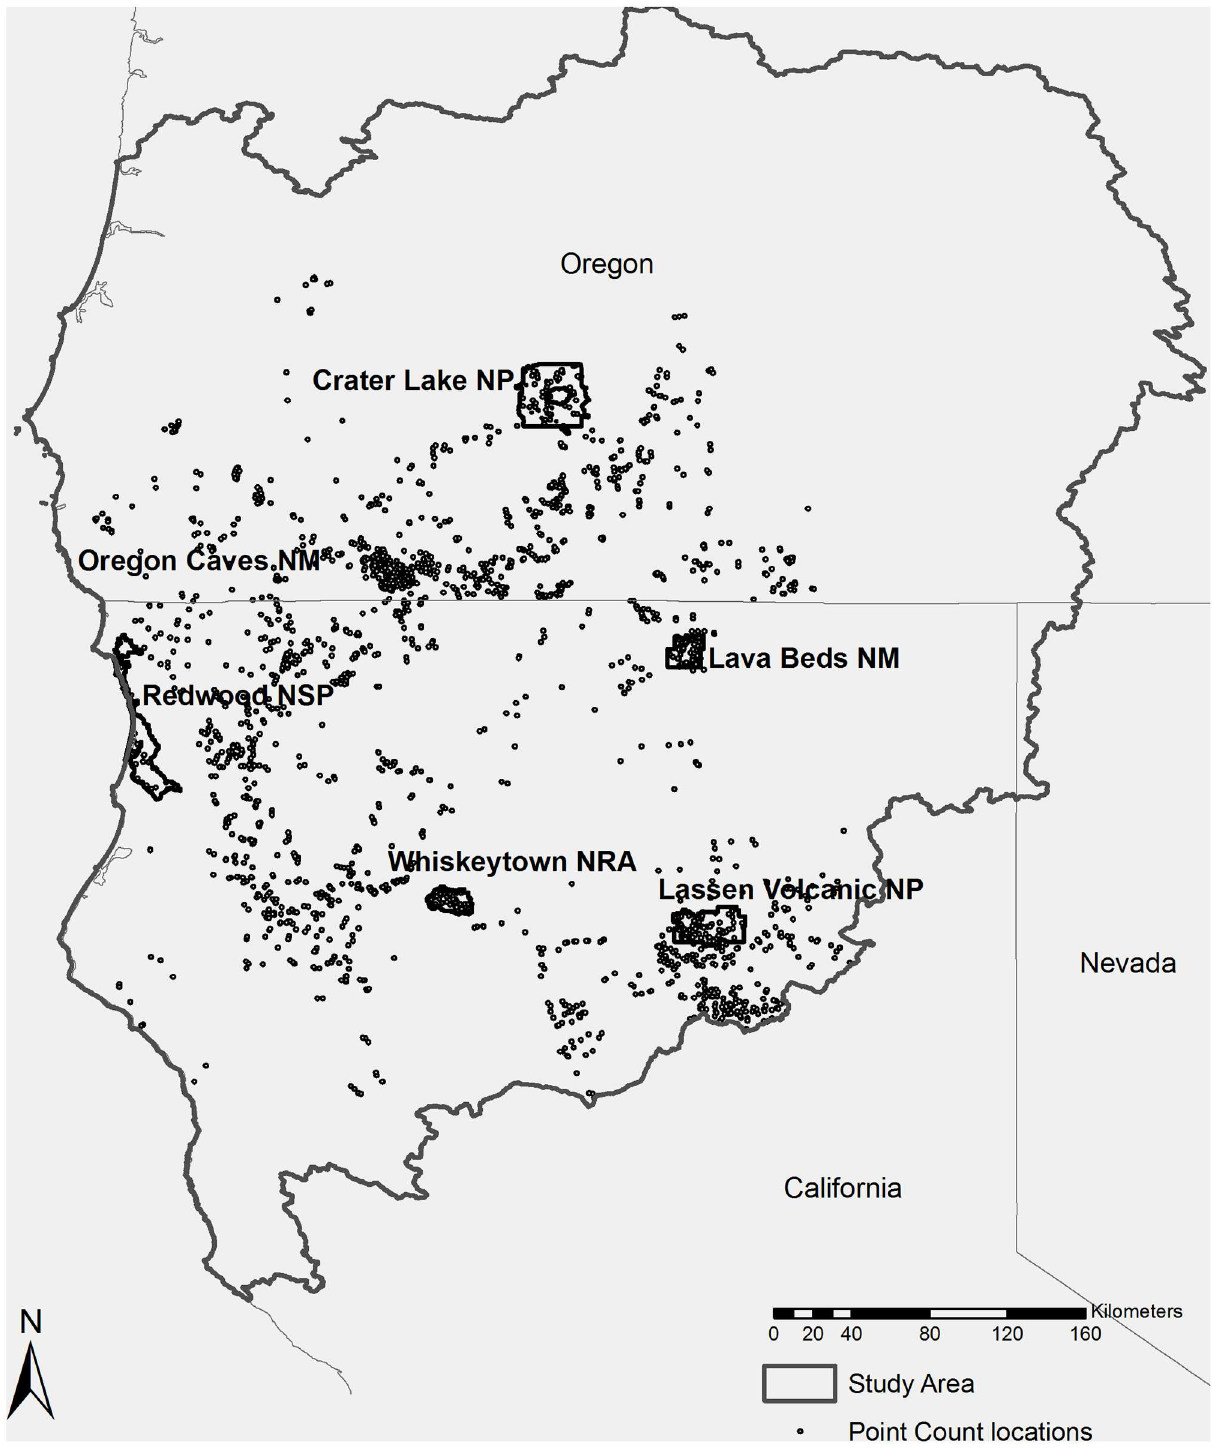
Fig 1. Study Area. The study area is defined by the Klamath Ecoregionlocated in northern Californiaand southern Oregon. Final analyses included 1990 bird survey points (see methods); 259 were located within the six NationalPark Service park units.